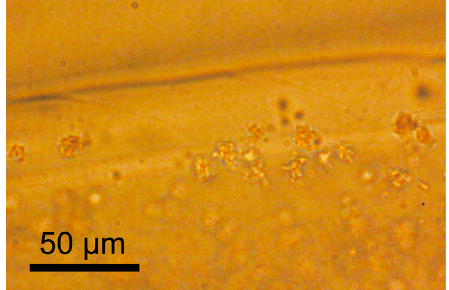
Figure 4. Micrograph showing C. glutamicum in the microfiber.